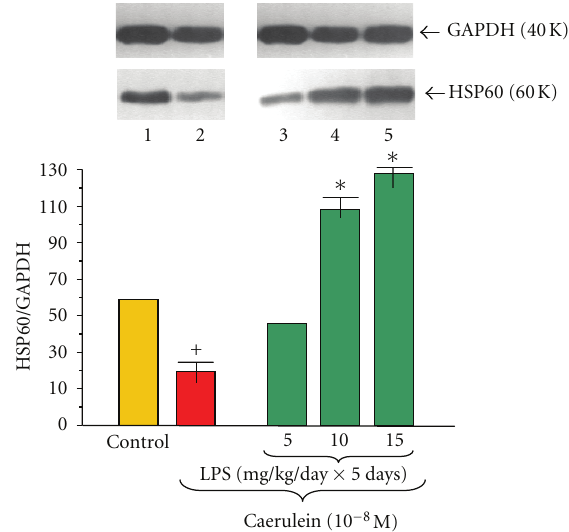
Figure 8: Western blot analysis of HSP60 protein level in the adult rat pancreatic acinar cells under basal conditions (lane 1), treated in the infant animals by lipopolysaccharide ( Escherichia coli ) at the doses of 5 mg/kg/day × 5 days (lane 2), 10mg/kg/day × 5 days (lane 3) and 15mg/kg/day × 5 days (lane 4) after 5 hours of incubation. The blots were stripped and probed with GAPDH to document equal protein loading. All presented results were obtained in 4 consecutive experiments and are representative of the observed phenomenon.